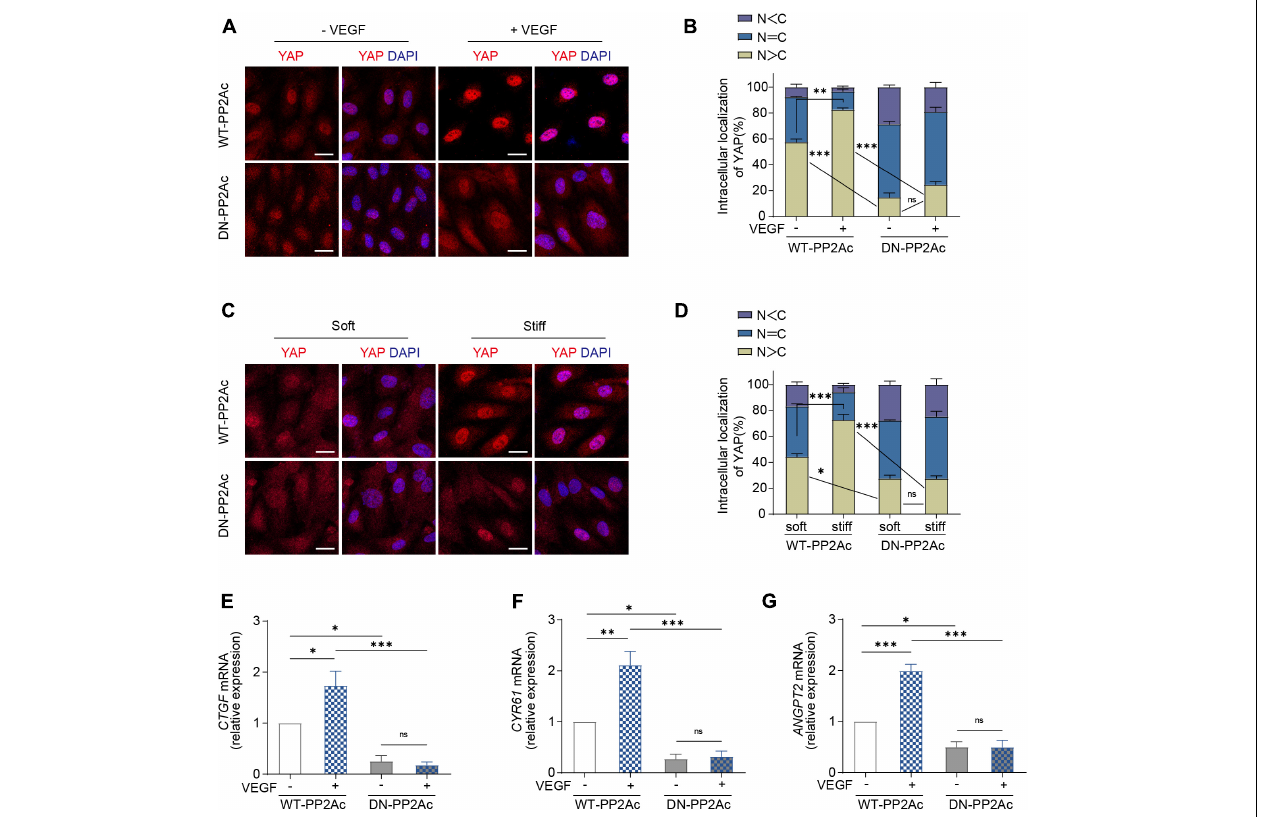
FIGURE 2 | VEGF or high stiffness activation of YAP requires PP2A activity. (A) Representative images of YAP localization in HUVECs infected with WT-PP2Ac, DN-PP2Ac adenovirus for 24 h, starved in 2% FBS medium for another 12 h, and treated with or without 50 ng/mL VEGF for 3 h. (B) Quantification of YAP cellular localization for HUVECs treated as in (A) . Approximately 200 cells from 12 random fields of view from three independent experiments were quantified. N, nucleus; C, cytosol. (C) HUVECs were infected with WT-PP2Ac, DN-PP2Ac adenovirus for 36 h. The cells were then trypsinized and seeded on soft (0.2 kpa) and stiff (20 kpa) hydrogels. After 3 h, the cells were fixed and stained for YAP and DAPI. (D) Quantification of YAP cellular localization in HUVECs treated as in (C) . N, nucleus; C, cytosol. (E–G) Relative mRNA level of CTGF (E) , CYR61 (F) , and ANGPT2 (G) in HUVECs infected with WT-PP2Ac, DN-PP2Ac adenovirus, serum starved and stimulated with 50 ng/mL VEGF. Data are shown as mean ± SEM, one-way ANOVA followed by Tukey’s multiple comparisons test. ∗ p < 0.05, ∗∗ p < 0.01, ∗∗∗ p < 0.001, ns indicates not significant. Scale bars, 20 µ